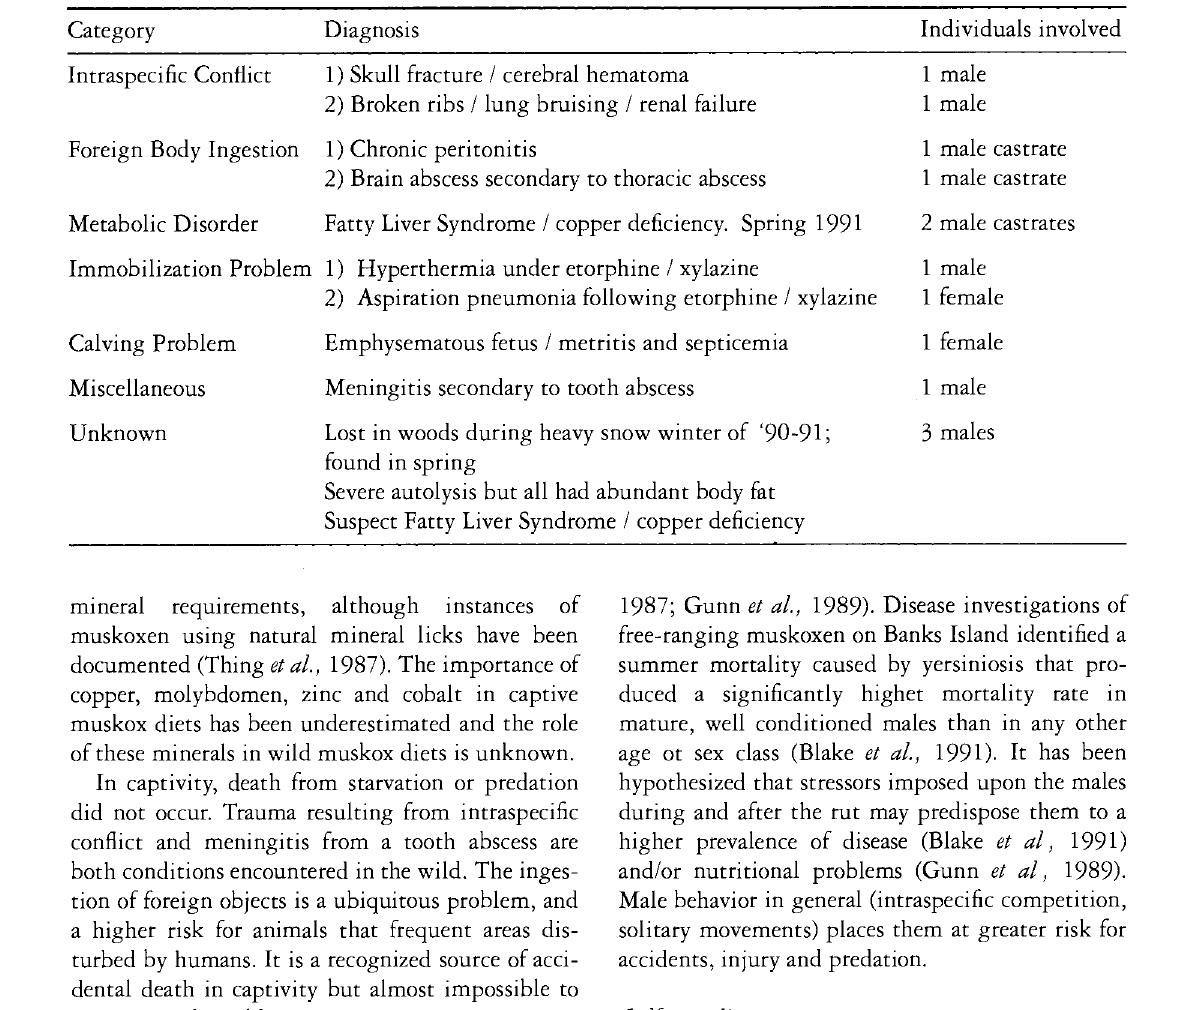
Table 1. Description of adult muskox mortality (>1 year old) at the Large Animal Research Station, 1988-1994.